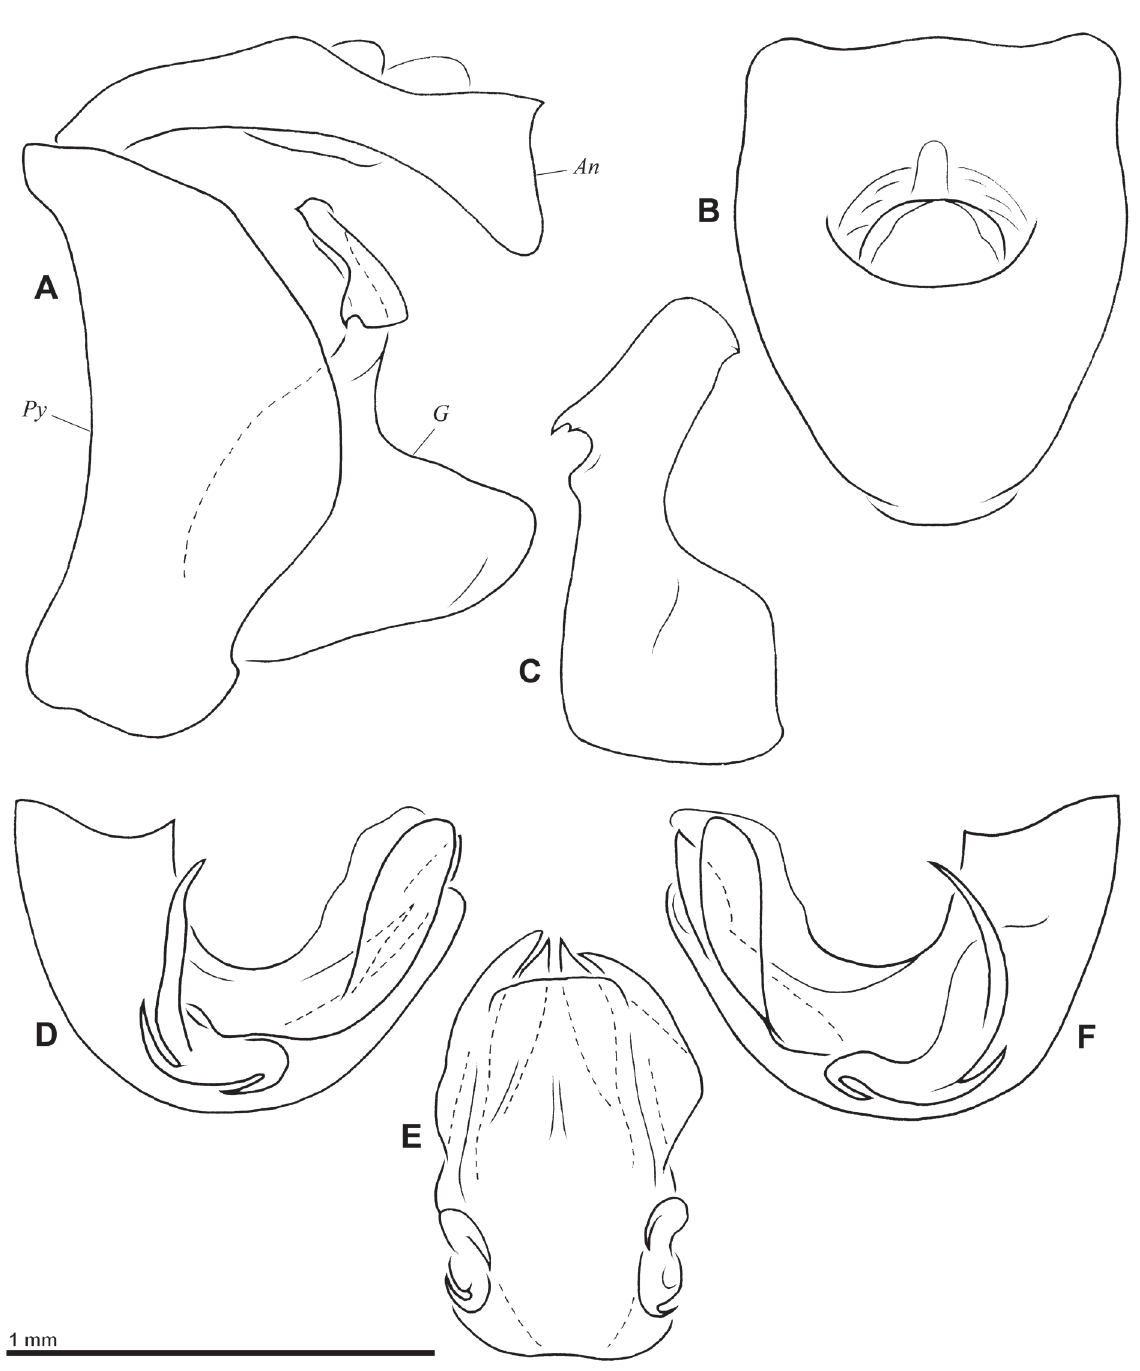
Fig. 2. Gergithoides gnezdilovi sp. nov., ♂, genitalia. A . Pygofer, anal tube and gonostylus, left lateral view. B . Anal tube, dorsal view. C . Left gonostylus, posterior view. D . Aedeagus, left lateral view. E . Aedeagus, posteroventral view. F . Aedeagus, right lateral view. Abbreviations: An = anal tube; G = gonostylus; Py